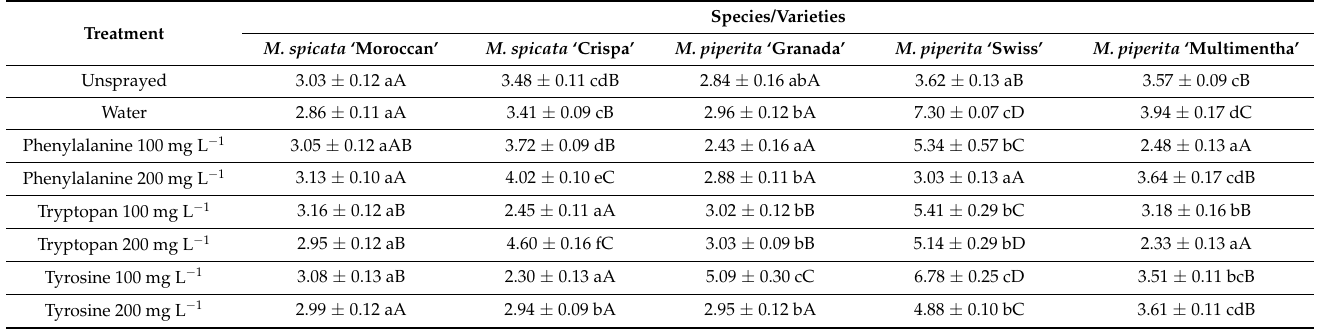
Table 3. Isoquercetin content in mint influenced by foliar application of amino acids, mg 100 g − 1 DM in 2017–2018.